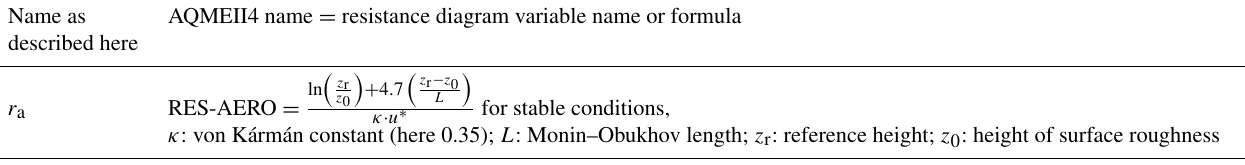
Table B4. AQMEII4-reported gaseous deposition variables corresponding to the LOTOS-EUROS resistance model of Fig. B4. Name